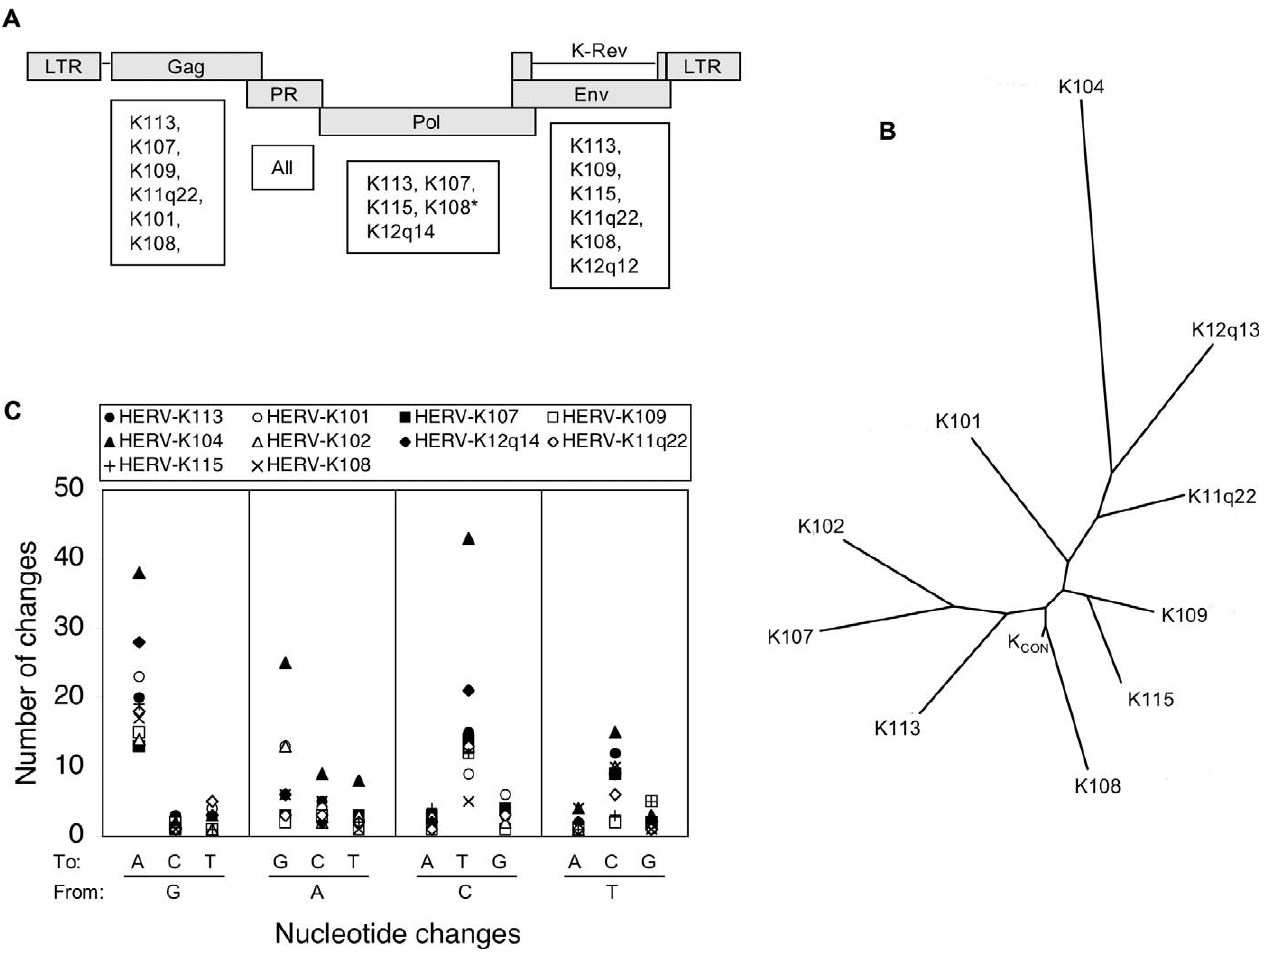
Figure 1. Design and Analysis of a Consensus HERV-K Provirus (A) Diagram of HERV-K(HML-2) provirus. ORFs are depicted as boxes. Proviruses used in the design of HERV-K CON that contain intact versions of Gag, protease, Pol, and Env are listed under each ORF (*K108 encodes a full-length Pol ORF, but a presumed essential YIDD motif is mutated). (B) Phylogenetic analysis of HERV-K CON and the ten proviruses used to generate it, constructed using Kimura 2-parameter algorithm in the TreeMaker program after gap-stripping the sequence alignment (http://www.hiv.lanl.gov/content/hiv-db/CONTAM/TreeMaker/TreeMaker.html). (C) Comparison of HERV-K CON with the ten HERV-K proviruses. Each contributing provirus was compared to HERV-K CON using HYPERMUT, and the number of nucleotide differences for each provirus relative to HERV-K CON is